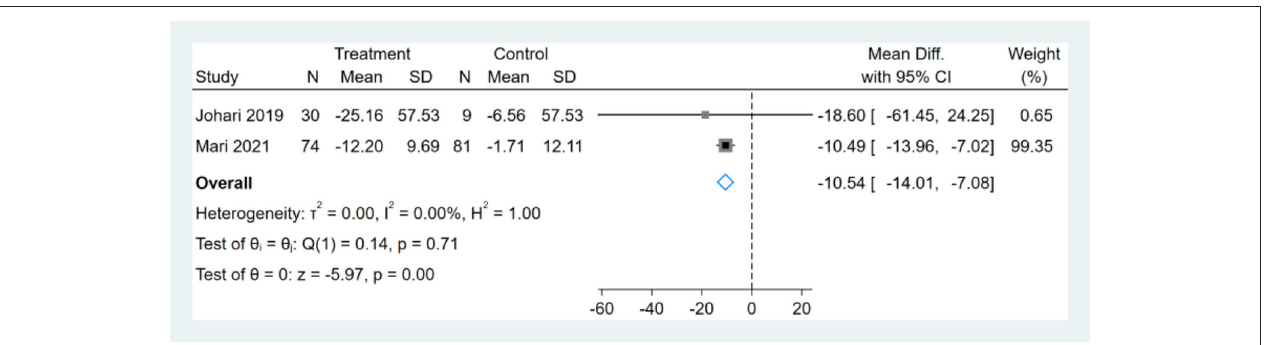
FIGURE 8 | Forest plot analysis showing changes in alanine aminotransferase (ALT).